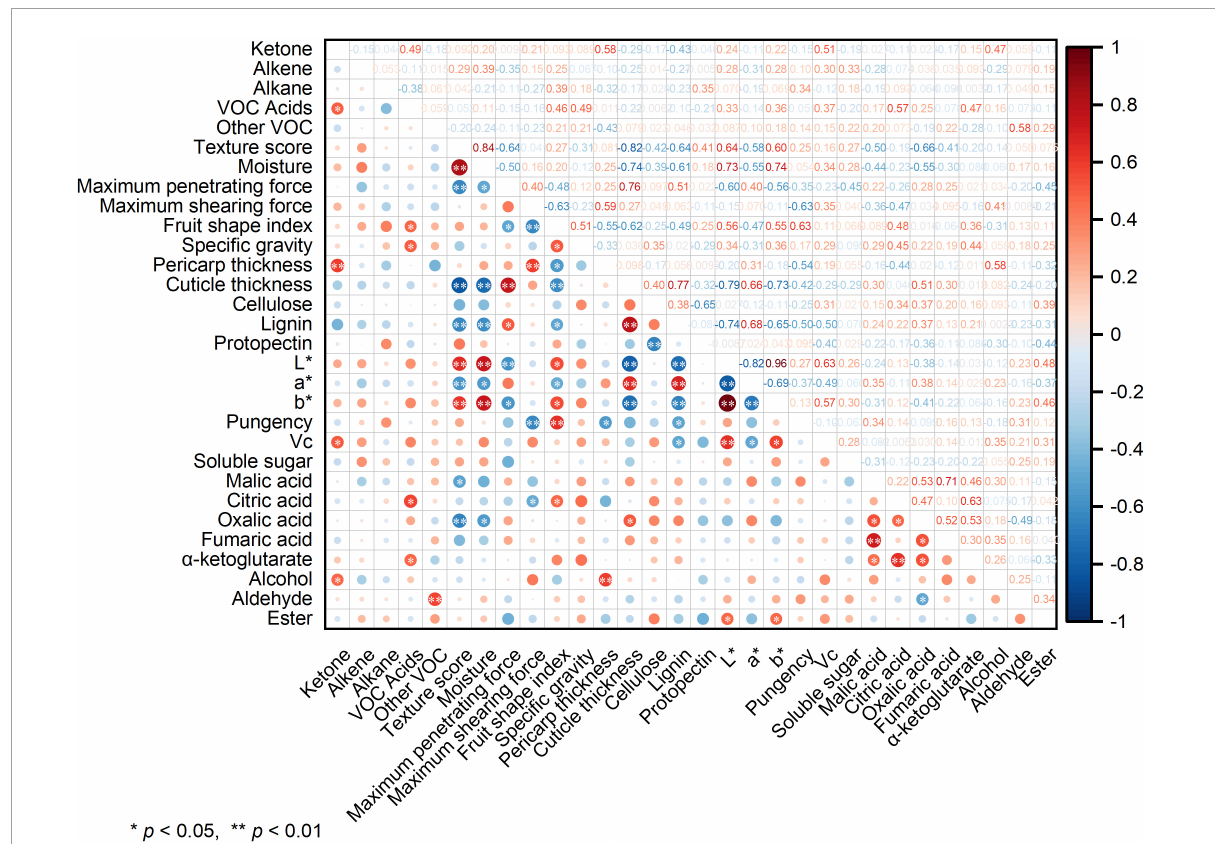
FIGURE7 Heat map of the Pearson correlation analysis. Values are Pearson’s correlation coefficients. ∗ and ∗∗ denote correlation coefficients that are significant at the p < 0.05 and 0.01 level,